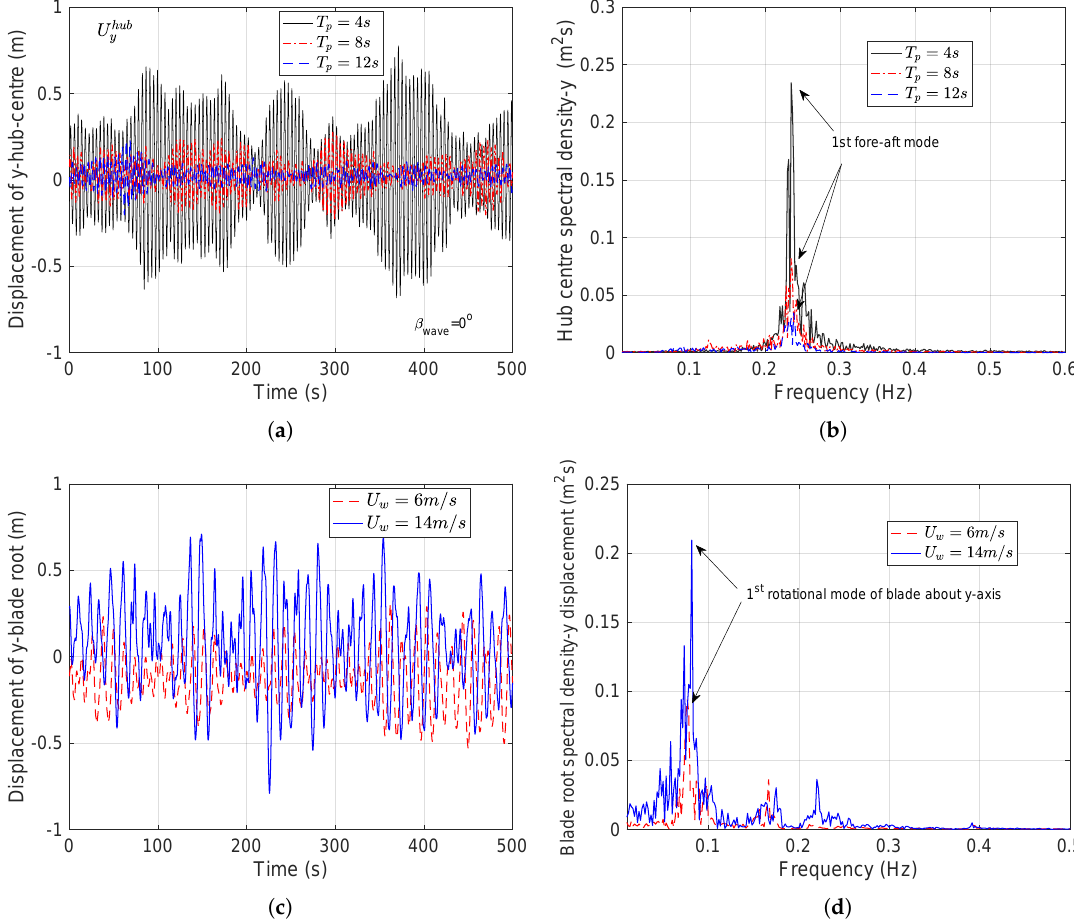
Figure 9. ( a ) Displacement hub-center y displacement ( U hub y ) ( b ) Spectral densities ( c ) Blade root y displacement ( d ) Spectral